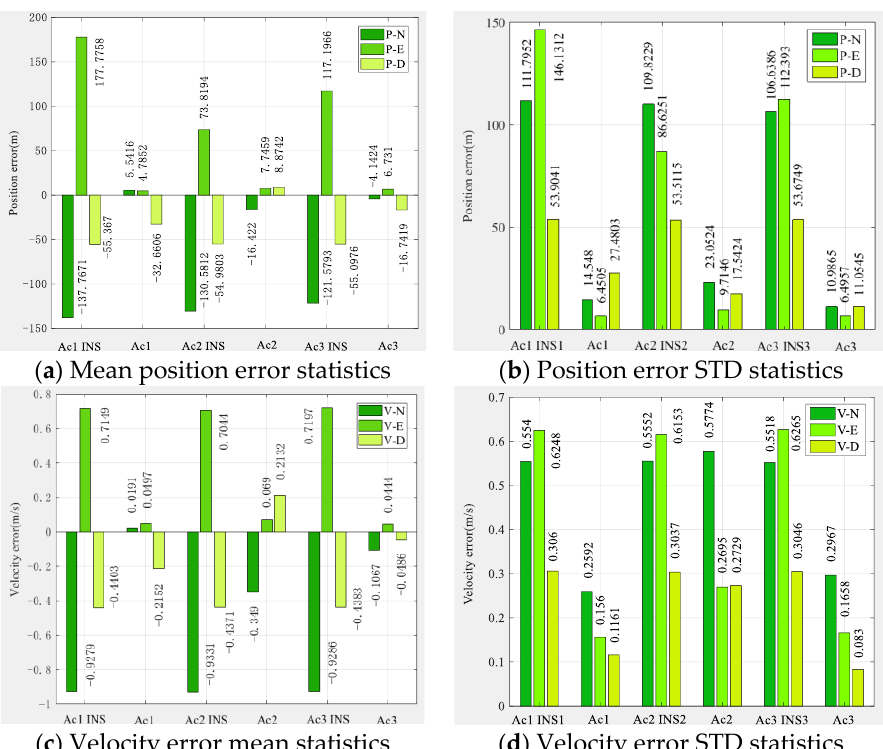
Figure 7. Statistical histogram of the multi-aircraft cooperative navigation and positioning indicators of the DWAPC-TSM system without the aid of an